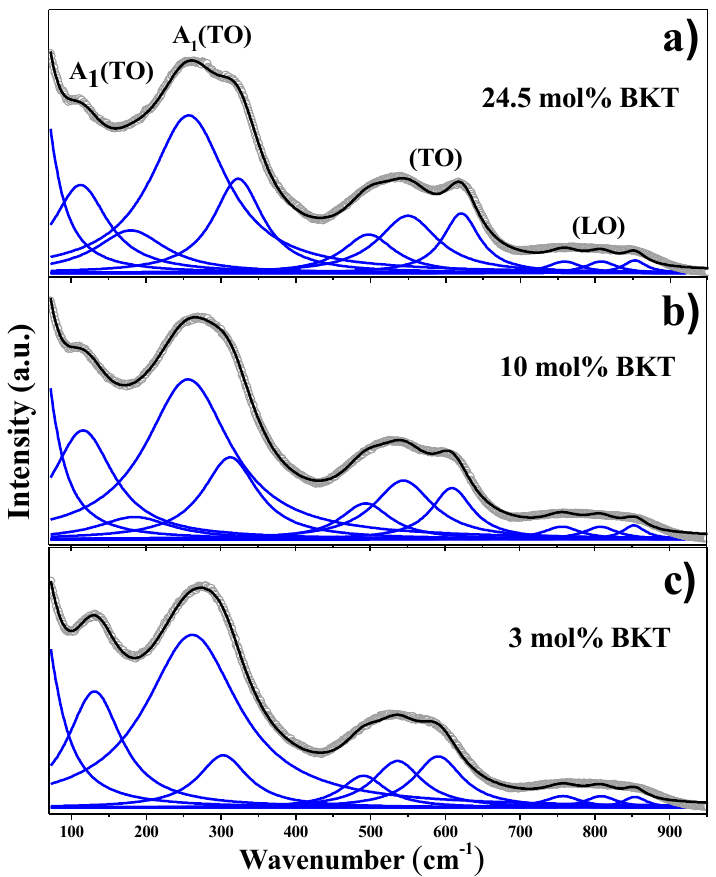
Figure 3. Deconvolution of Raman spectra from sintered ceramics with ( a ) 24.5 mol % BKT; ( b ) 10 mol % BKT; and ( c ) 3 mol % BKT. The gray and dark lines correspond to the experimental and deconvoluted curves, respectively.